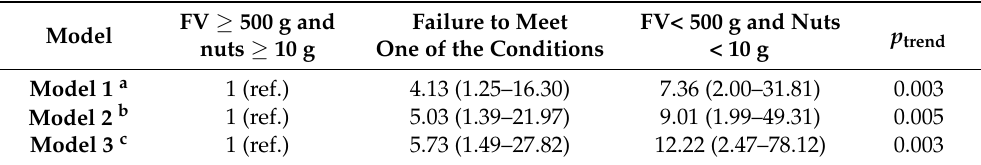
Table 5. The odds ratio for the relationship between the consumption of vegetables, fruits, and nuts and developing COVID-19. FV ≥ 500 g and Failure to Meet Model nuts ≥ 10 g One of the Conditions